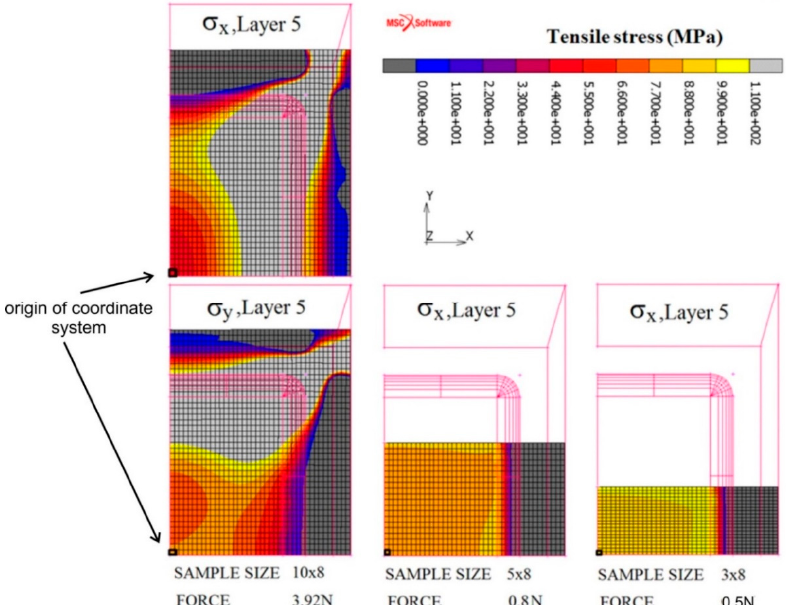
Figure 5. Simulated tensile stresses in x ( σ x ) and y ( σ y ) directions in the fifth layer of the shell model of the FeCoB samples; R B × R A : 10 × 8 ( σ x , σ y —left panel), 5 × 8 ( σ x —middle panel), and 3 × 8 ( σ x —right panel). The values at the bottom are pressure forces of the micrometric screw.